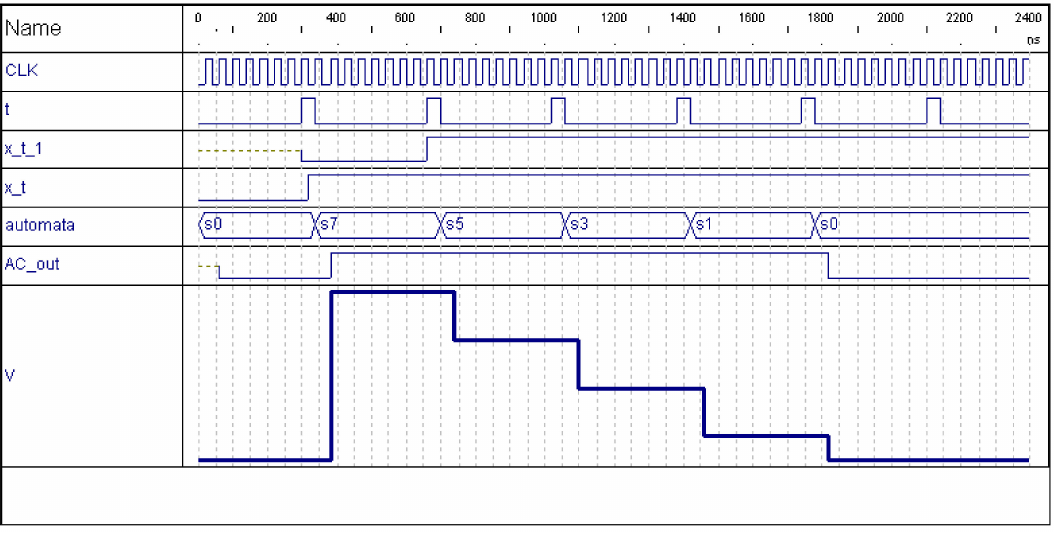
Figure 2. Evolution of the automata on an isolated image pixel (8